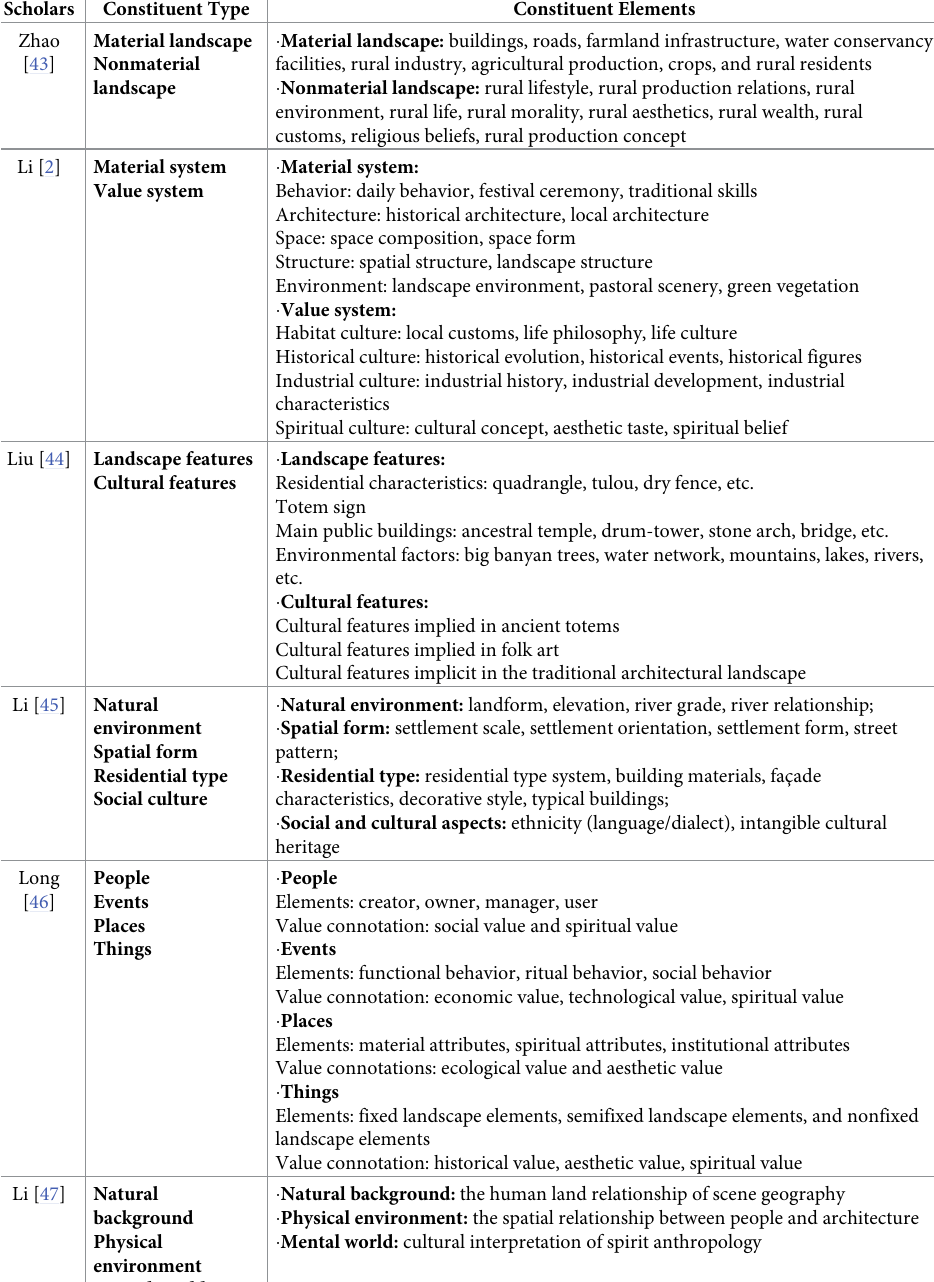
Table 1. Cultural landscapes of traditional settlements and constituent